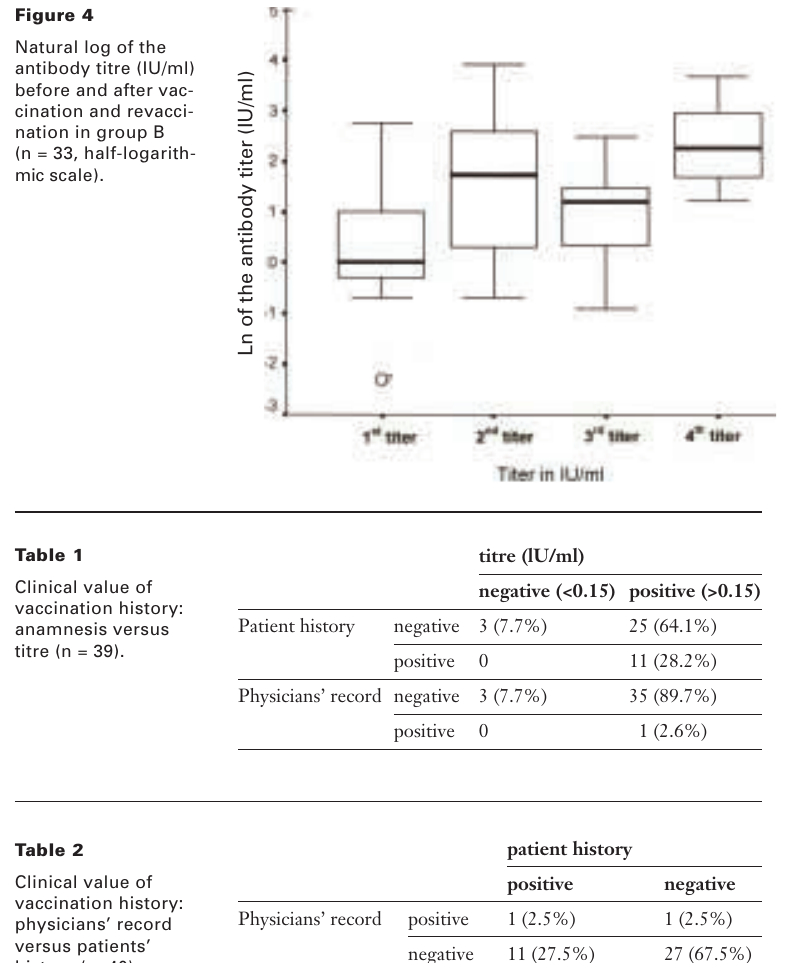
Natural log of the antibody titre (IU/ml) before and after vac- cination and revacci- nation in group B (n = 33, half-logarith- mic